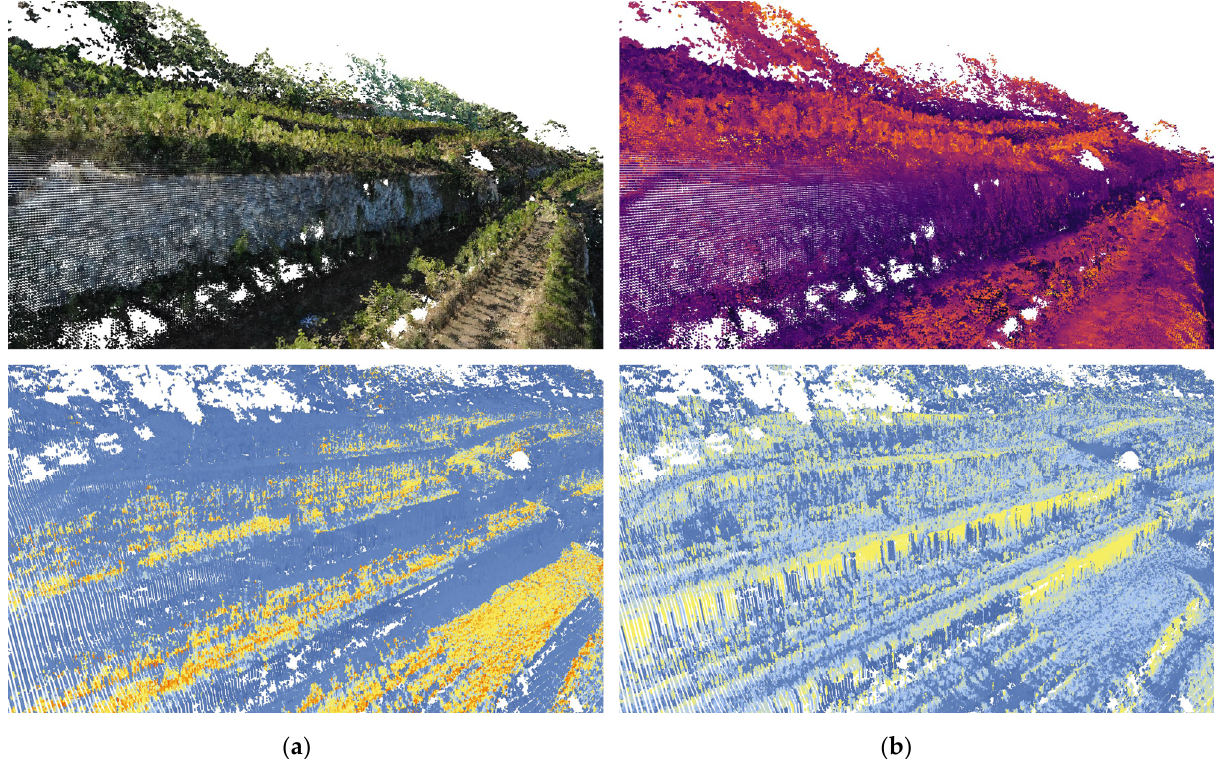
Figure 7. Images of a photogrammetric voxel model that encodes both geometric data and surface temperature measured during the UAV TIR acquisition. The resolution of this dataset allows for investigations at the feature scale, addressing relations between dry-stone walls and plants. The amount of captured points varies in the time series, depending on the quality of a single photogrammetric acquisition. The photogrammetric dataset presented here was used to construct the digital surface model and conduct incoming solar radiation analysis. In the bottom row, exemplary outcomes of the radiation analysis in the morning ( a ) and late afternoon ( b ) are presented.